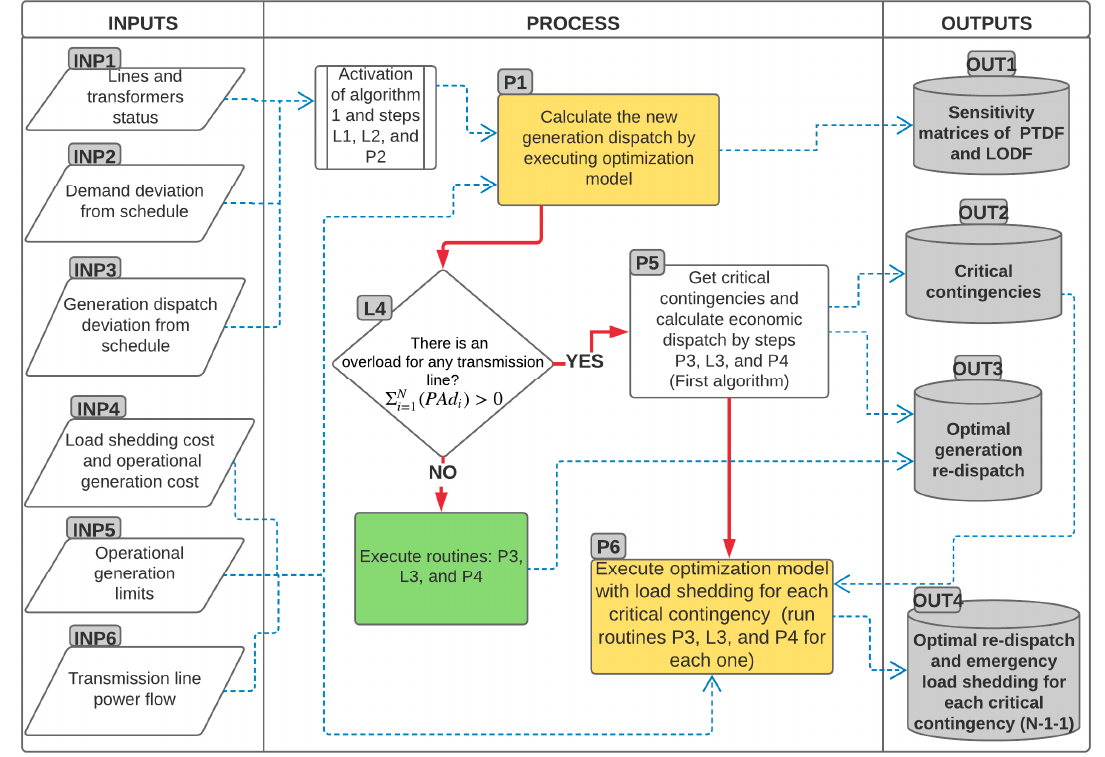
Figure 2. Second algorithm for the online dispatch with load shedding after critical contingencies.